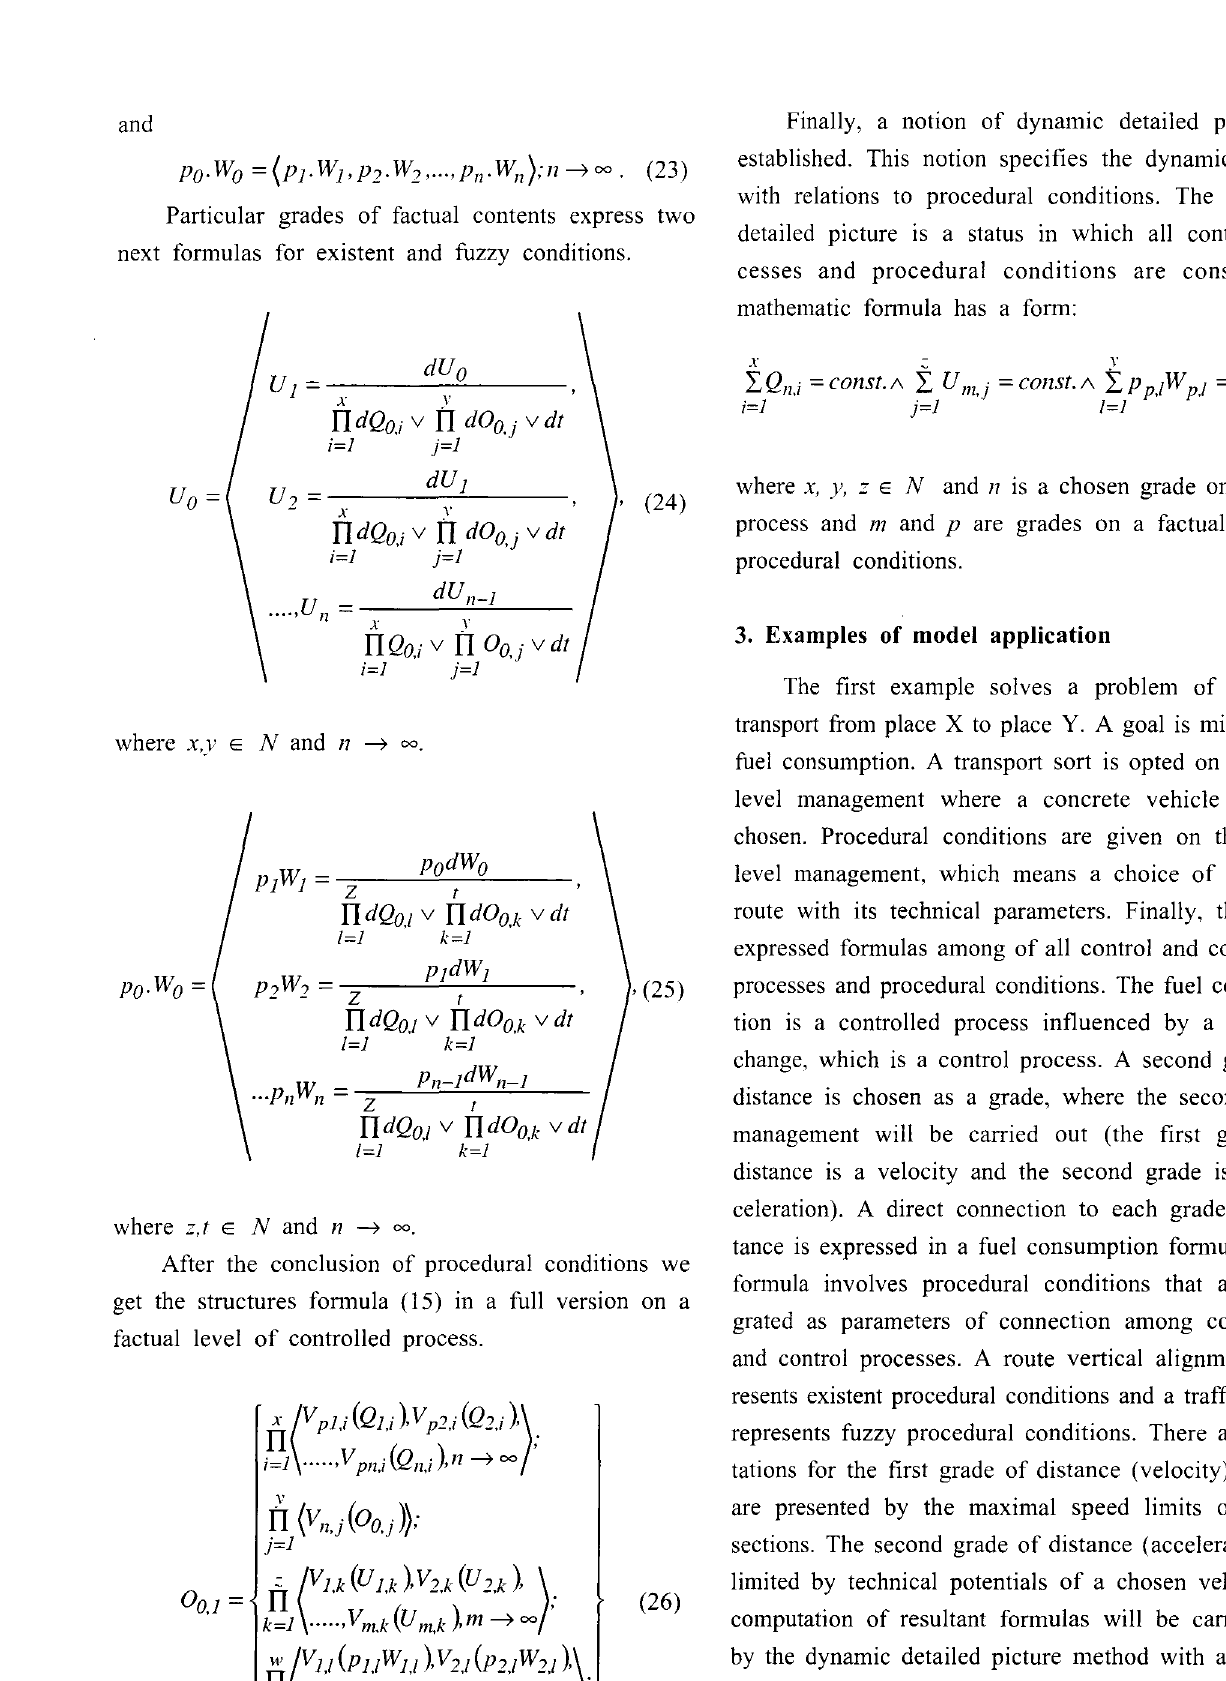
next formulas for existent and fuzzy